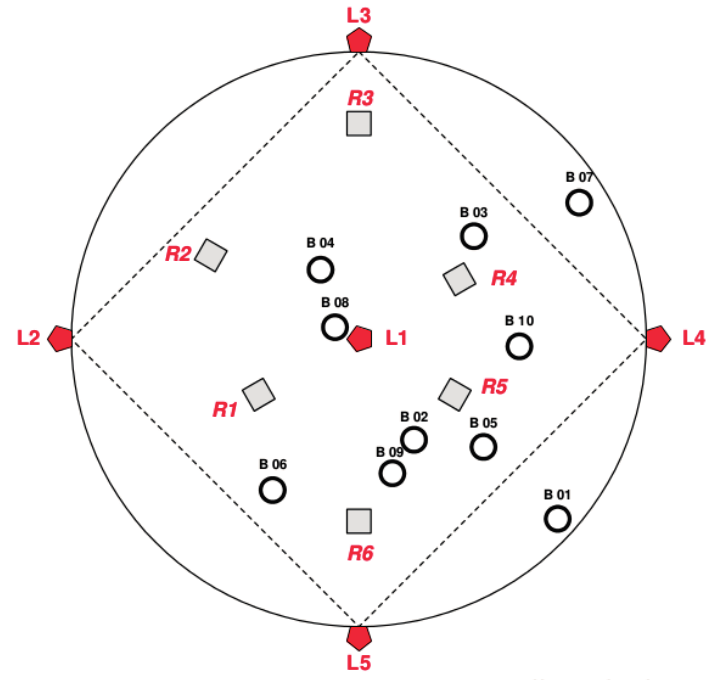
Figure 1. Schematic view of Plot 1: The L i (red pentagons) show the position of the TLS. The R i (gray squares) show the position of the six reference targets used for scan placement. The B i (black circles) show the positions of the ten polystyrene balls marking out the calibration volume